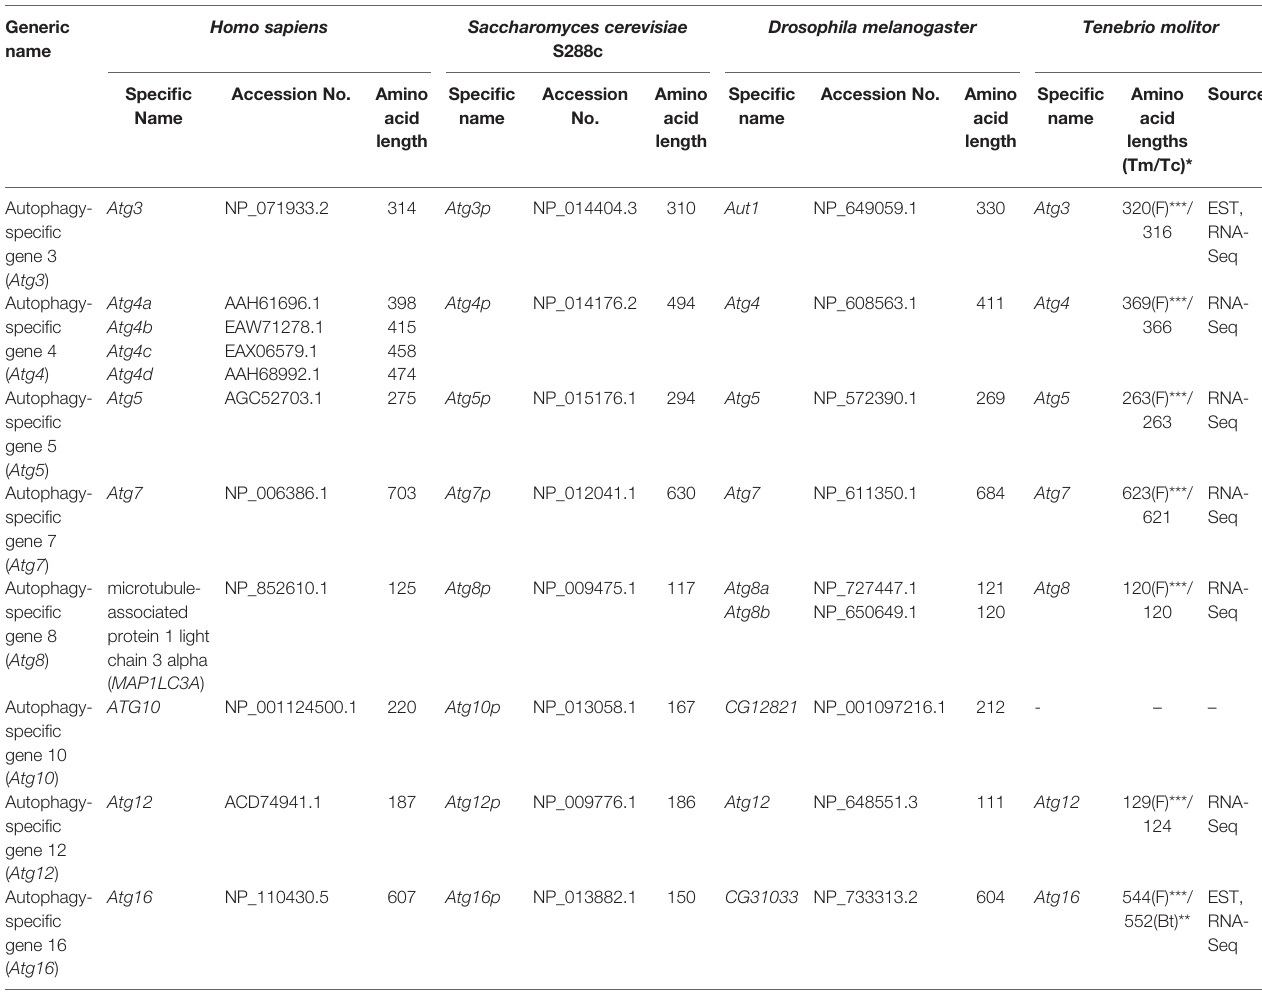
TABLE 4 | Autophagy related genes involved in elongation and completion in T. molitor